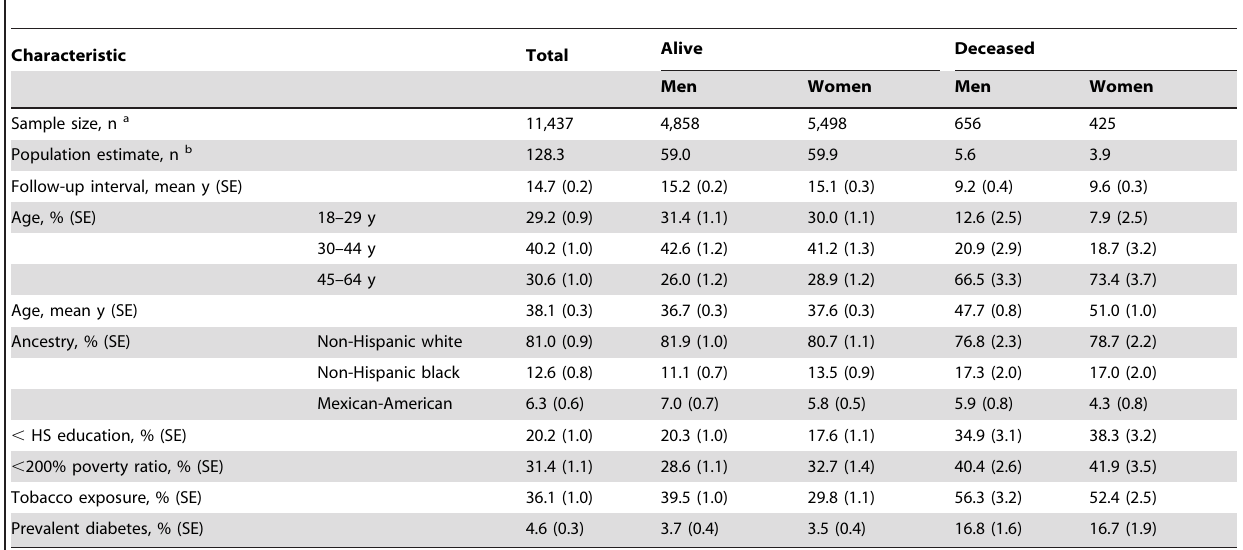
Table 1. Selected baseline characteristics of U.S. adults aged 18–64 years, NHANES 1988–1994.